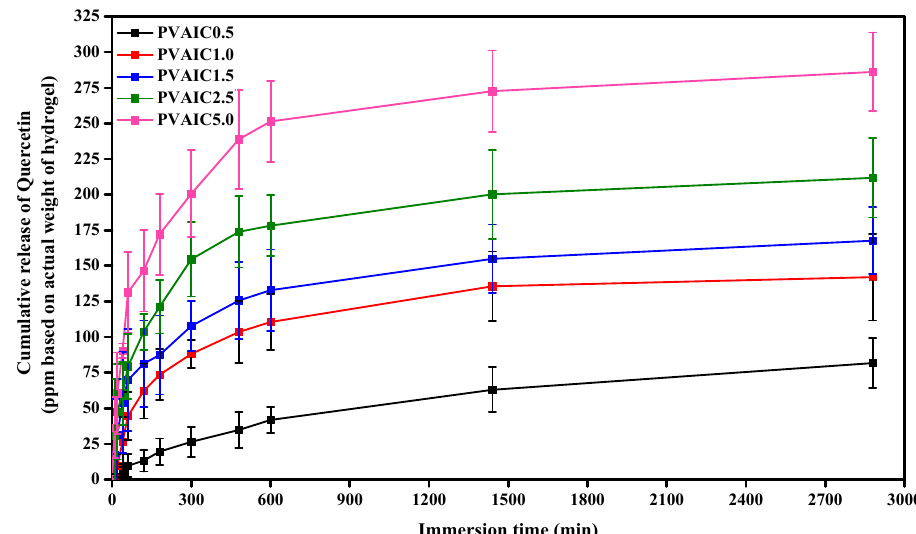
Figure 5. Release profiles of quercetin from PVA hydrogels containing 0.5% (PVAIC0.5), 1.0% (PVAIC1.0), 1.5% (PVAIC1.5), 2.5% (PVAIC2.5), and 5.0% (PVAIC5.0) of quercetin/HP- β -CD inclusion complex. Data shown as mean ± standard deviation ( n = 3).